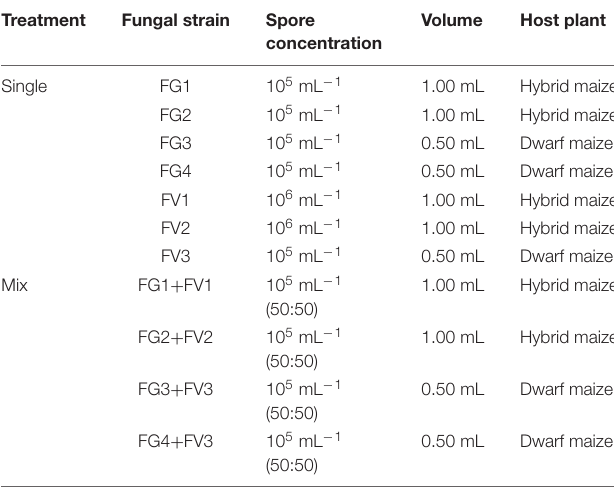
TABLE 2 | Infection of maize plants with Fusarium